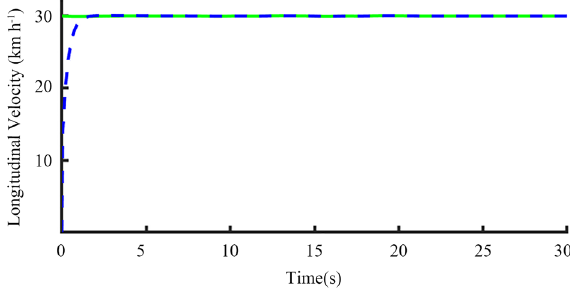
Figure 19. Graph of the desired and actual longitudinal velocity at the